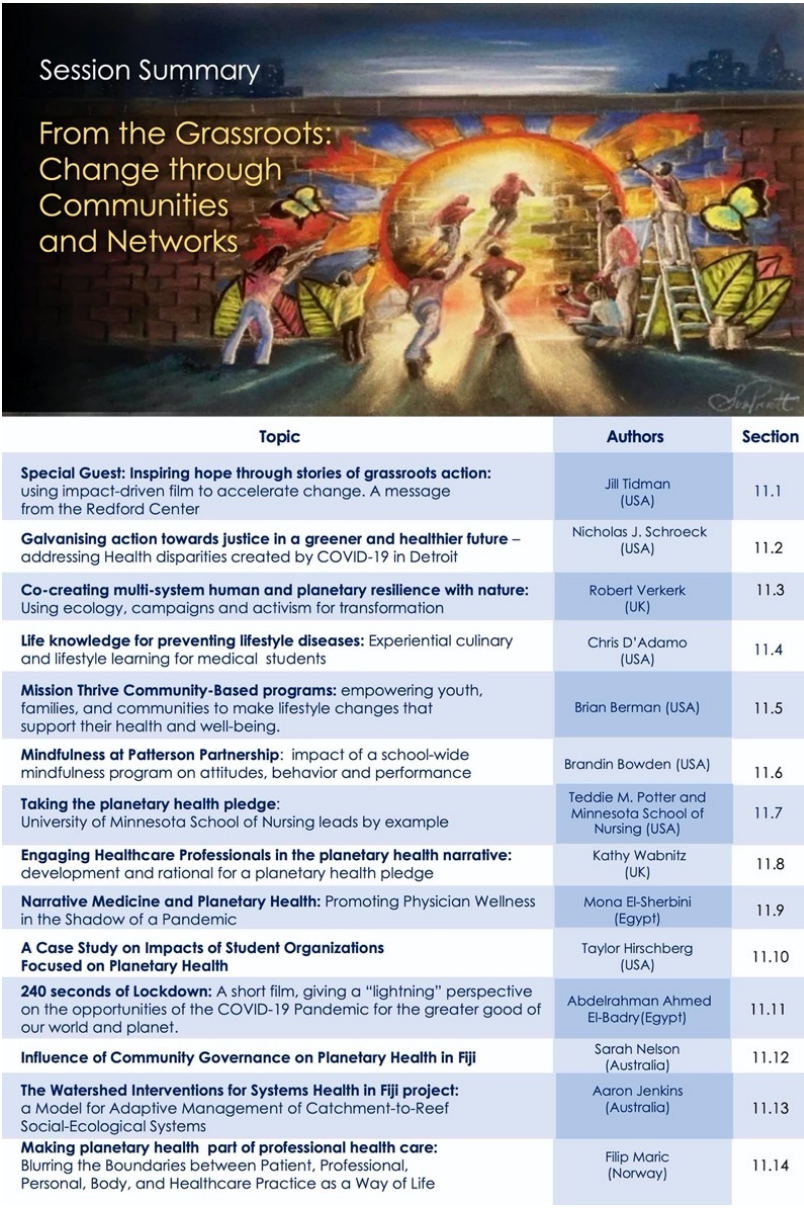
Figure 10. Making change through communities and networks: Overview of topics and speakers in the session on grassroots engagement.